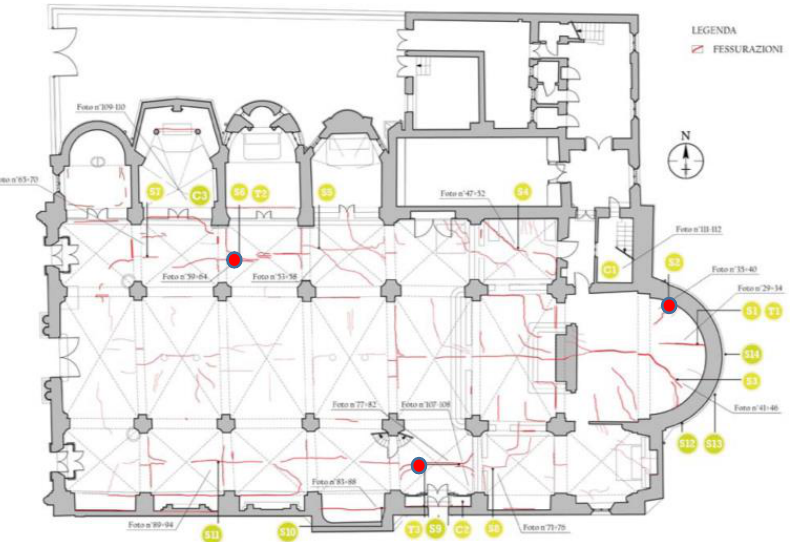
Figure 12. Plan of the St. Bassiano church with representation of the crack pattern and sensor location. The three red points represent the monitored cracks reported in the next Figures 13 and 14.